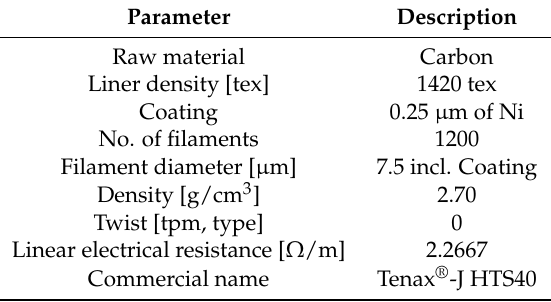
Table 1. Characteristics of nickel-coated carbon yarn (NiCCY) [14] .